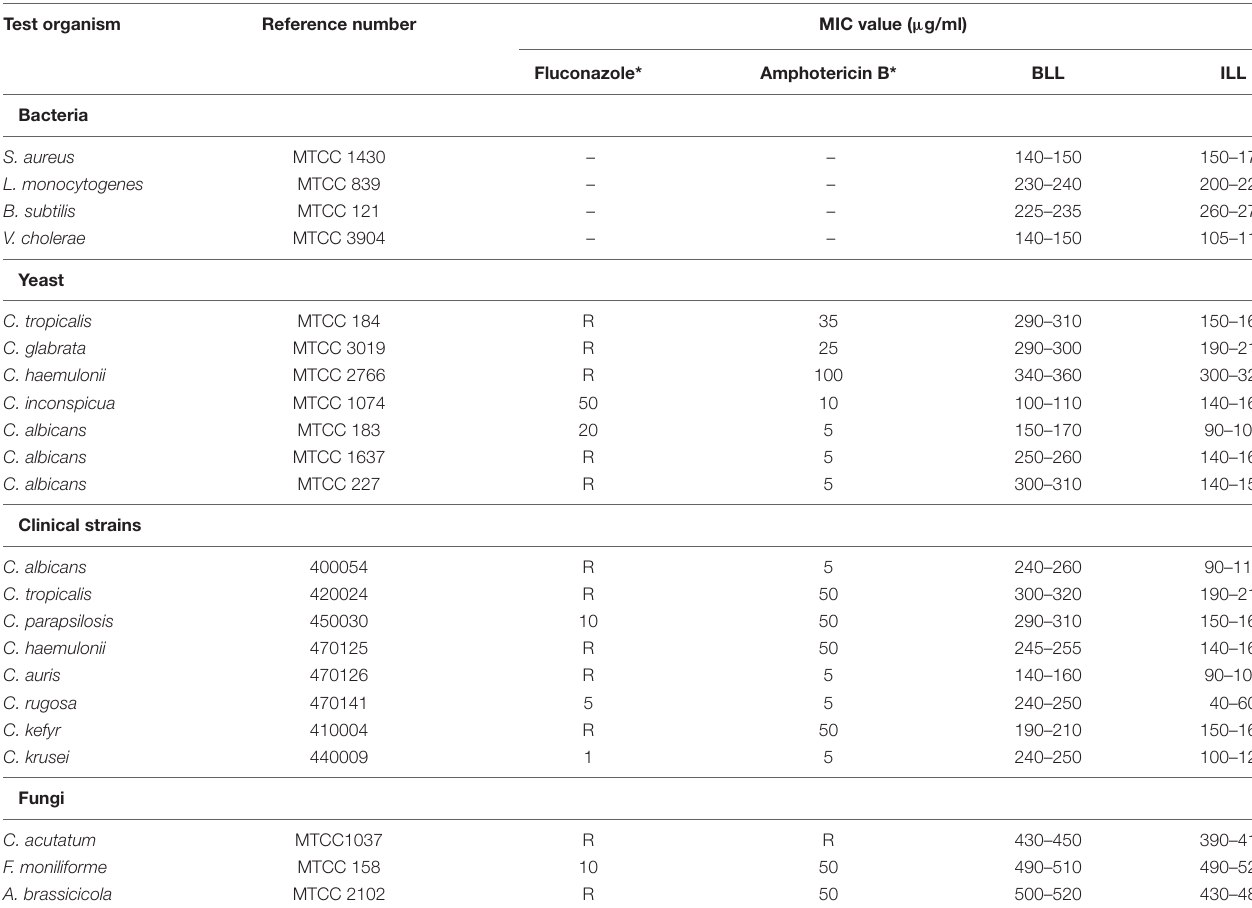
TABLE 2 | Determination of minimum inhibitory concentrations (MIC) against various indicator and clinical strains by ILL and BLL (concentration range of lipopeptides tested was 10–550 µ g/ml with 5 µ g/ml increments). Test